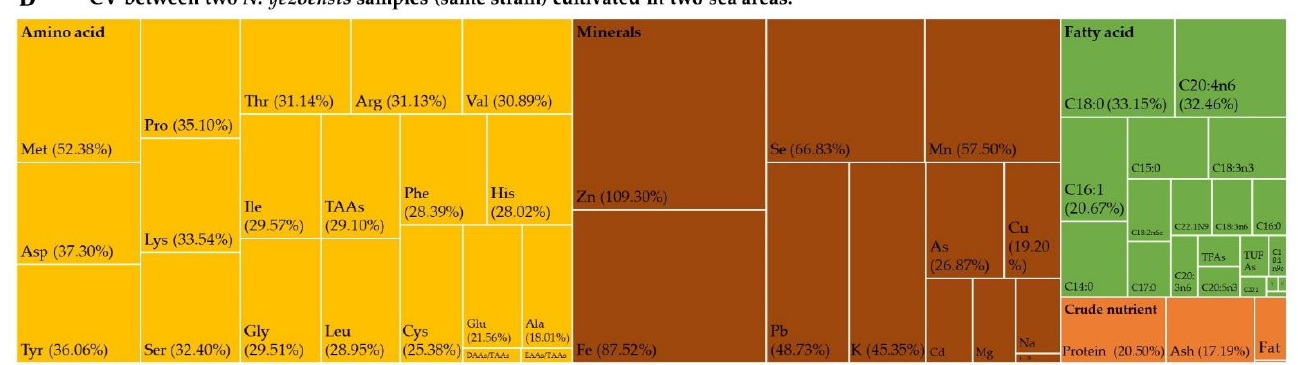
Table 3. Principal component analysis for nutritional components of N. yezoensis strains. Component Initial Characteristic Value